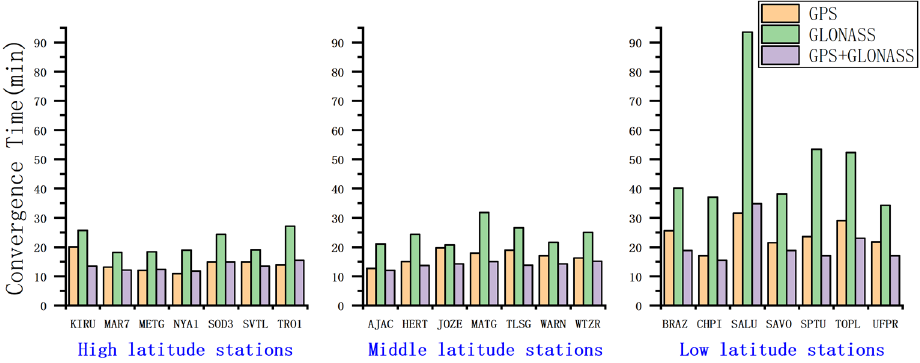
Figure 14. The convergence time of PPP. Table 10. The mean convergence time of PPP for each network and their comparison between different processing modes (The red values indicate the percentage reduction of convergence time and the green values indicate the percentage increment of convergence time).